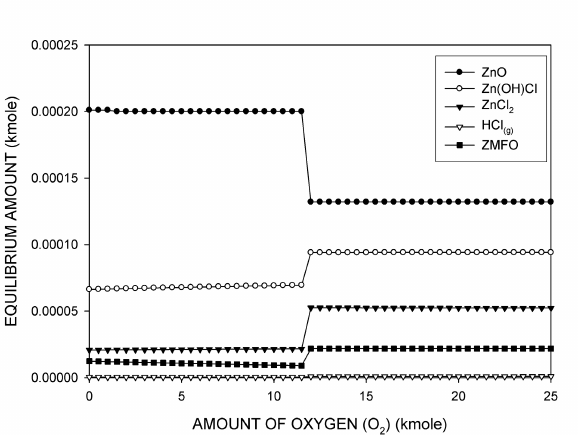
Figure 3(b). Effect of the amount of iron on the equilib- rium amounts of the zinc-containing species and gaseous HCl for the Zn-Fe-Mn-O-H-C-Cl system.